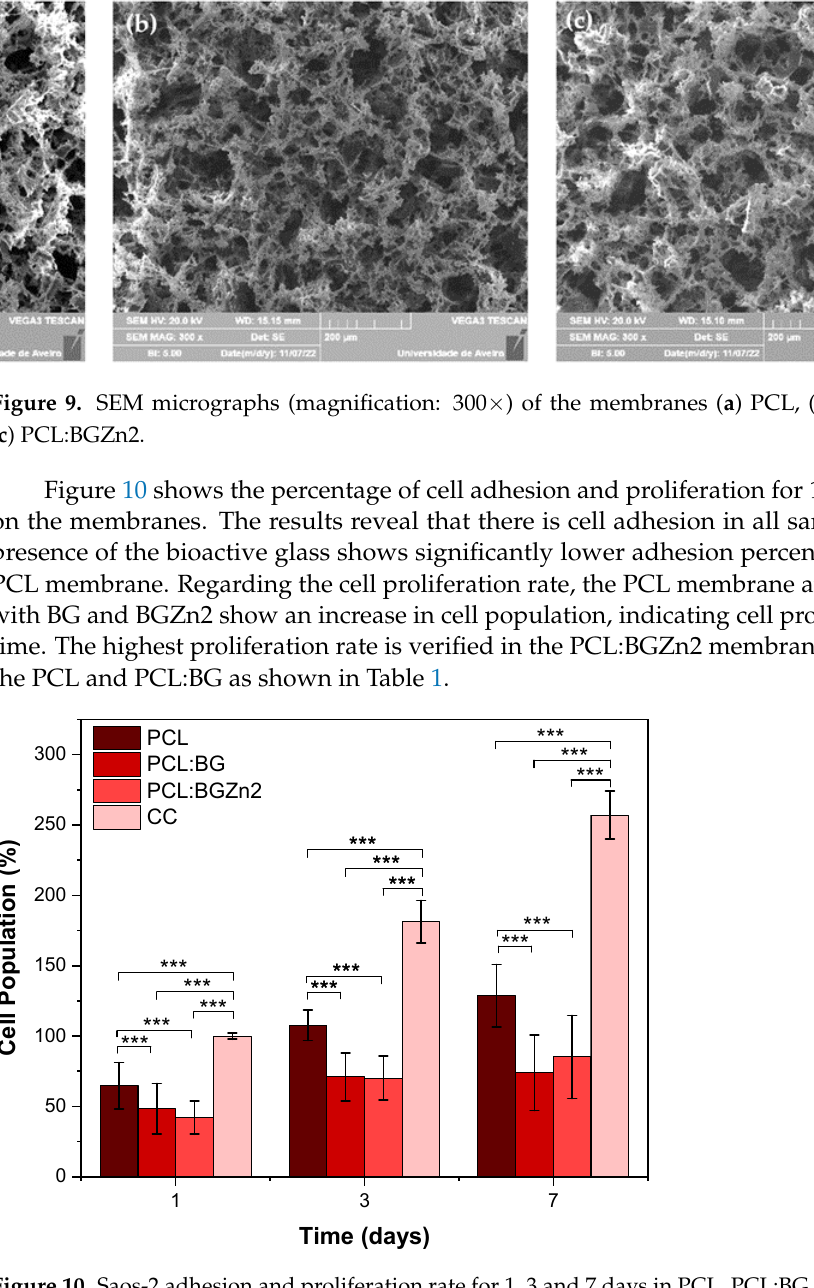
Figure 8. Values of the inhibition halo diameters of all samples against Gram-negative ( E. coli ) and